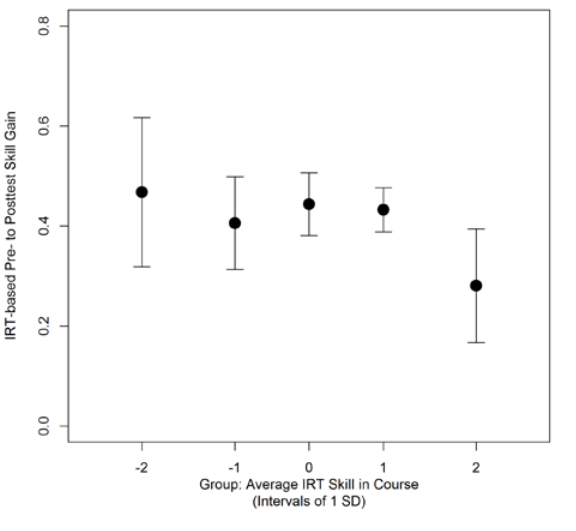
Figure 4 . The IRT-based pre- to posttest gain for students grouped by their overall ability (skill) in the